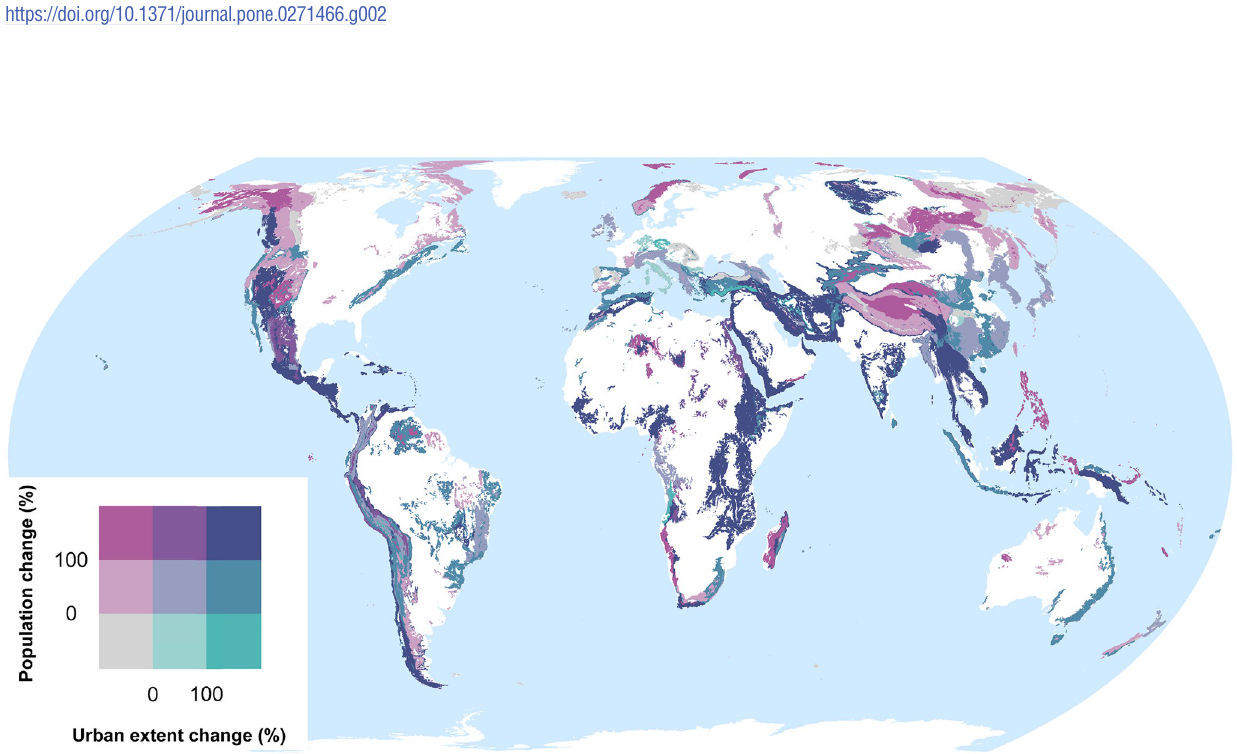
Fig 3. Bivariate choropleth map of total population count change (%) vs. urban extent change (%) between 1975 and 2015 by GMBA sub-mountain range zone according to the GHS-POP and GHS-SMOD datasets. Change values had to exceed the thresholds indicated to be placed in the higher category. Areas with declines in both metrics are shown in